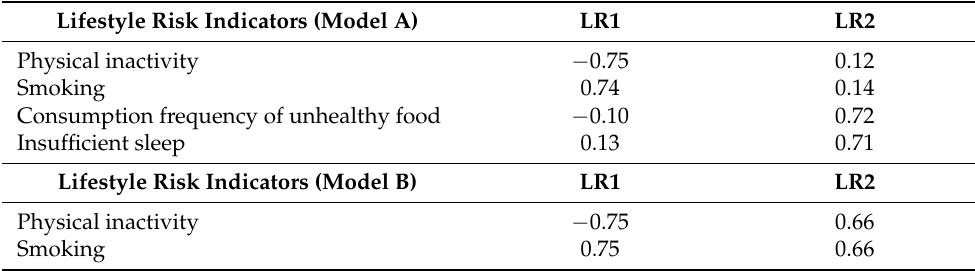
Table 2. Component matrix of the 2-component principal component analysis